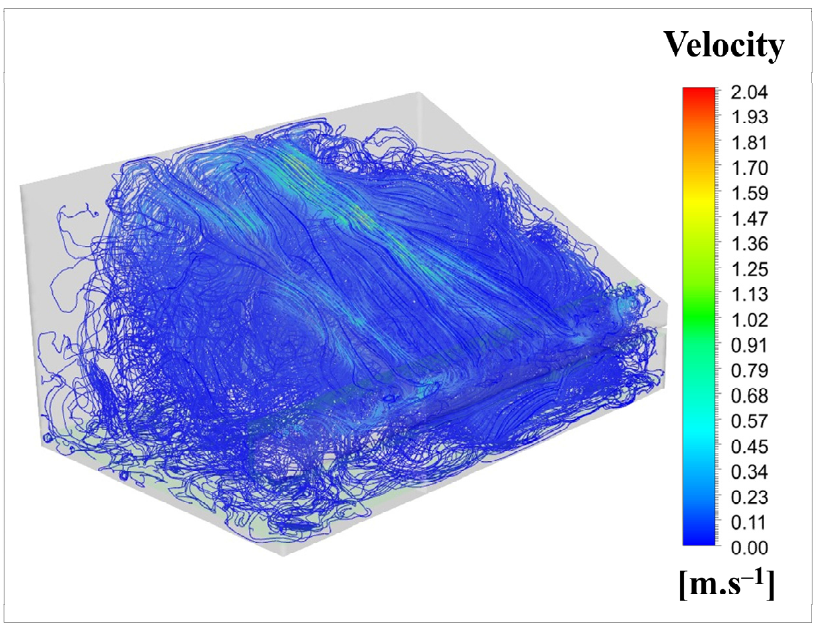
Figure 15. Mixing velocity for the 1 h time using streamlines for the proposed model.